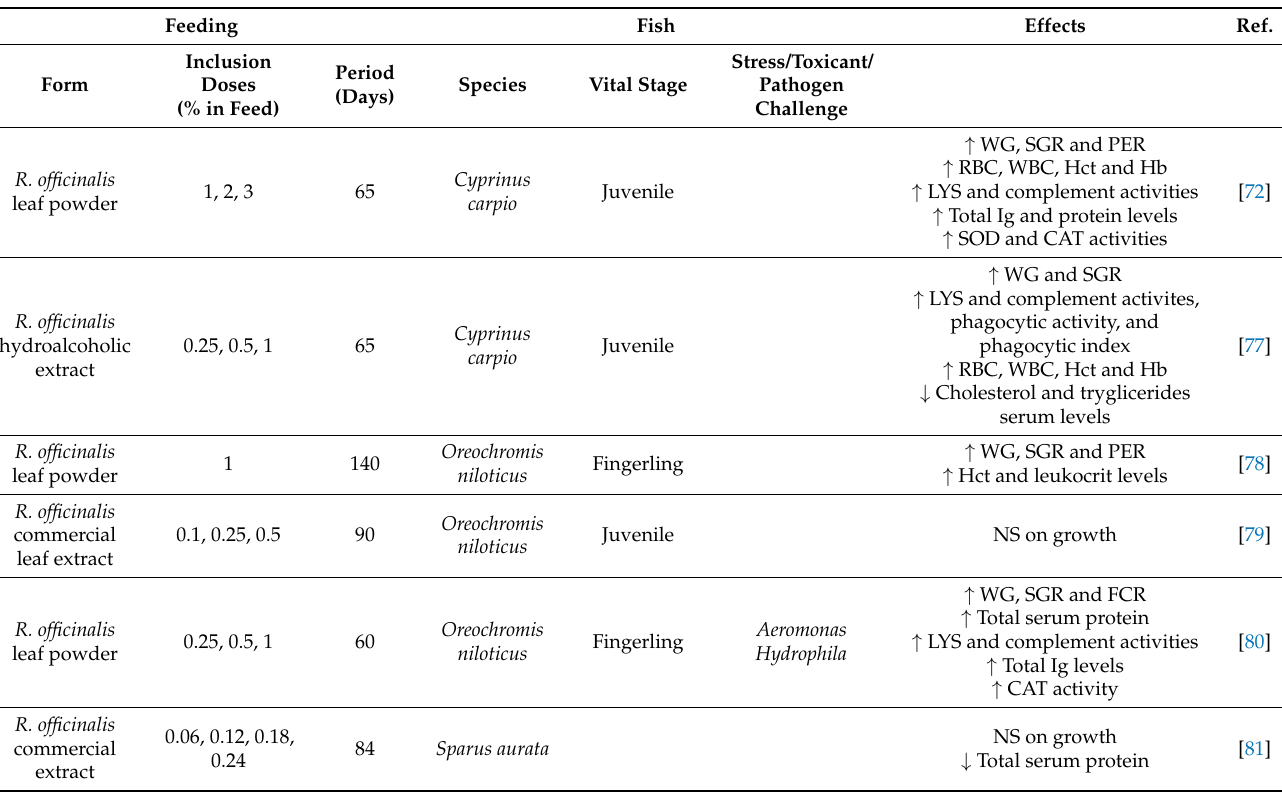
Table 2. Studies of rosemary products added to the feed of aquaculture